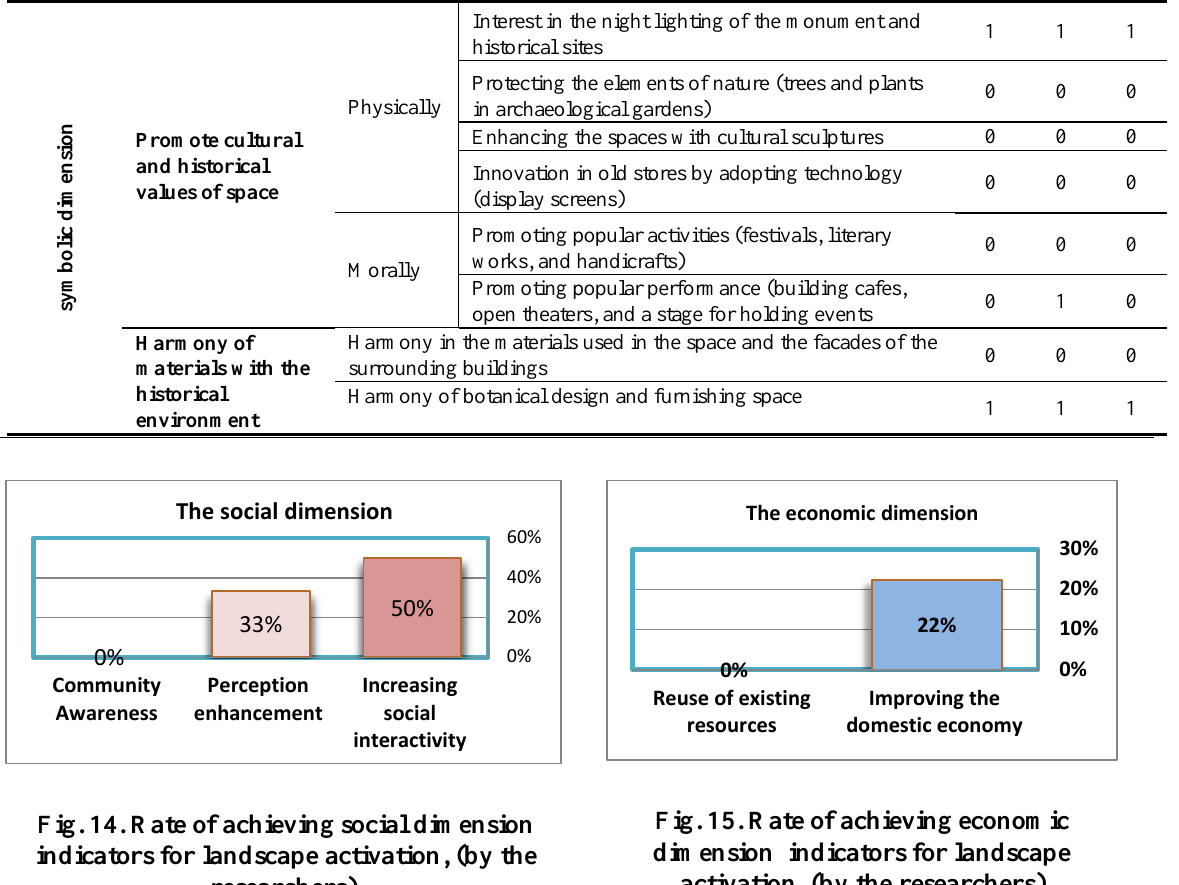
Fig. 14. Rate of achieving social dimension indicators for landscape activation, (by the researchers).